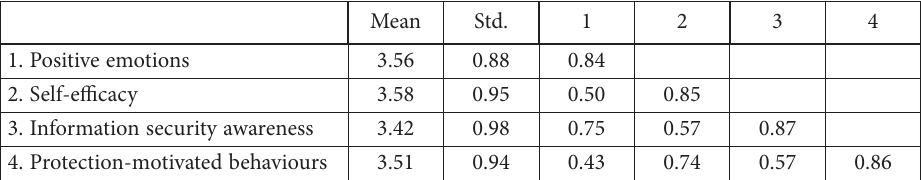
Table 4. Correlation analysis of latent variables